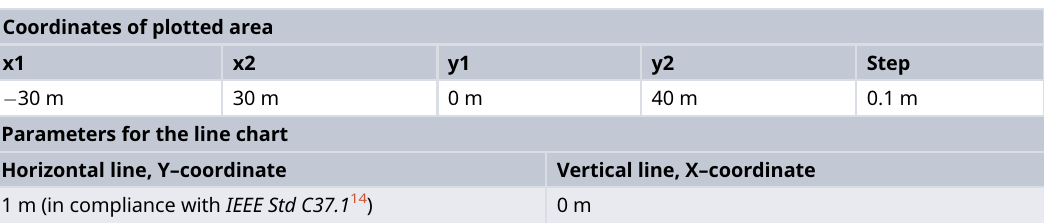
Table 1. Geometrical